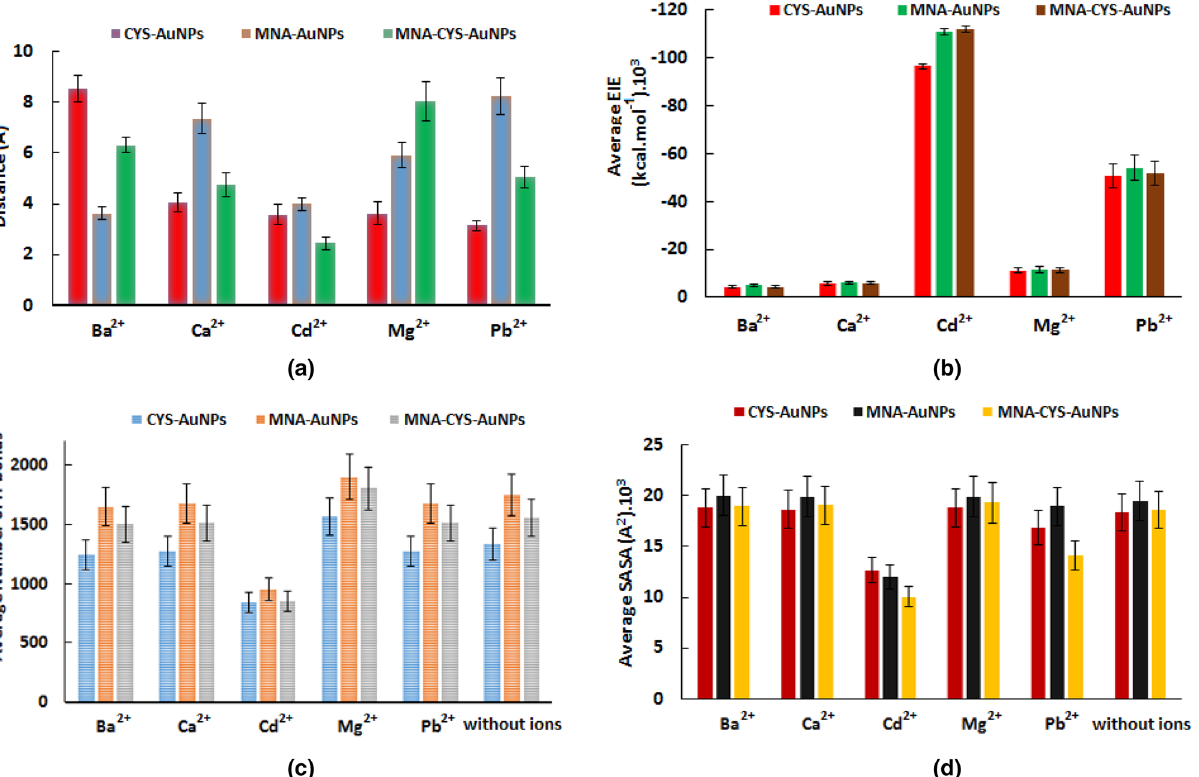
Figure 6. The calculated average distance ( a ) and average EIE ( b ) between the O atoms (of COO − group of MNA and CYS) and different metal ions and the average H-bond ( c ) between the functional groups and water molecules and the calculated SASA of the functionalized AuNPs ( d ) in the presence and absence of different metal ions. The average values were calculated during 50 ns MD simulations and the error bars show the calculated standard deviation of the corresponding Figure 8-a shows the 2D NCI plots of the reduced density gradient (RDG) versus the electron density for Cd 2+ complexes with MNA and CYS groups (2D NCI plots of other metal ion complexes are represented in Fig. S5). In the 2D NCI plot, three definite regions are specified by blue, green, and red colors, which reveal bonding, vdW, and repulsive interactions, respectively. According to Fig. 8-a, the negative values of sign (λ 2 )ρ confirm strong electrostatic interaction between Cd 2+ and the corresponding functional groups. The 2D NCI plot of Ba 2+ complexes indicates that this metal ion has only vdW interactions with MNA and CYS (Fig. S5) that is weaker than Cd 2+ interactions with these groups. This result confirms the MD simulation data and reveals that Ba 2+ due to weak interactions with functional groups cannot eliminate the repulsive interactions of the functionalized AuNPs. Moreover, on the basis of sign (λ 2 )ρ values, Cd 2+ and Pb 2+ have stronger electrostatic interactions with MNA and CYS groups in comparison with Mg 2+ and Ca 2+ , which is according to the MD simulation results. Figure 8-b shows the 3D NCI plots of Cd 2+ interactions with functional groups. In this figure, each interac- tion is represented by color-filled isosurfaces such as, red, blue and green, which reveal nonbonding, bonding and vdW interactions, respectively. The comparison between the obtained 3D NCI plots clearly shows that Cd 2+ and Pb 2+ (Fig. S6) have considerable interactions with CYS and MNA groups. According to Fig. S6, the green